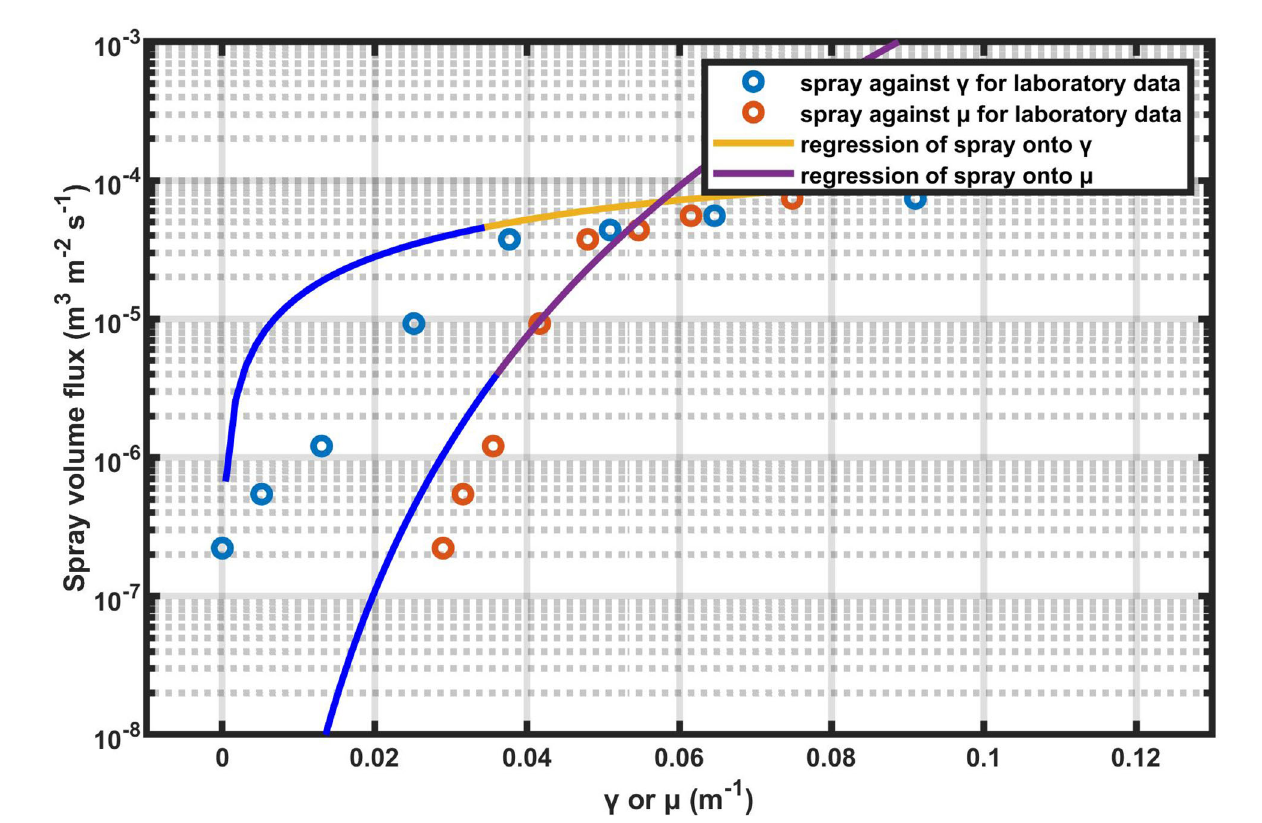
FIGURE 3 Regressions of spray volume fl ux onto g and m for the laboratory observations. The blue part of the regression line is in the range of g or m corresponding to the laser intensity in the fi eld observations (calculate from Equations 3, 5,